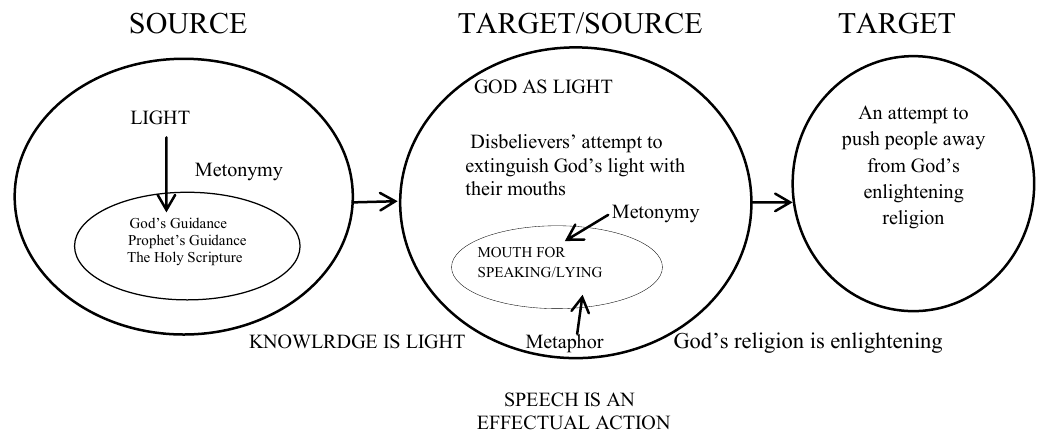
Figure 1 . Metaphoric complexes involved in the construction of the Qur’anic verse (9:32) However, the last parts of the verse, which are cases of full contrast and concession, defy disbelievers’ attempts to extinguish God’s light. This assures believers that God perfects his light, or saves